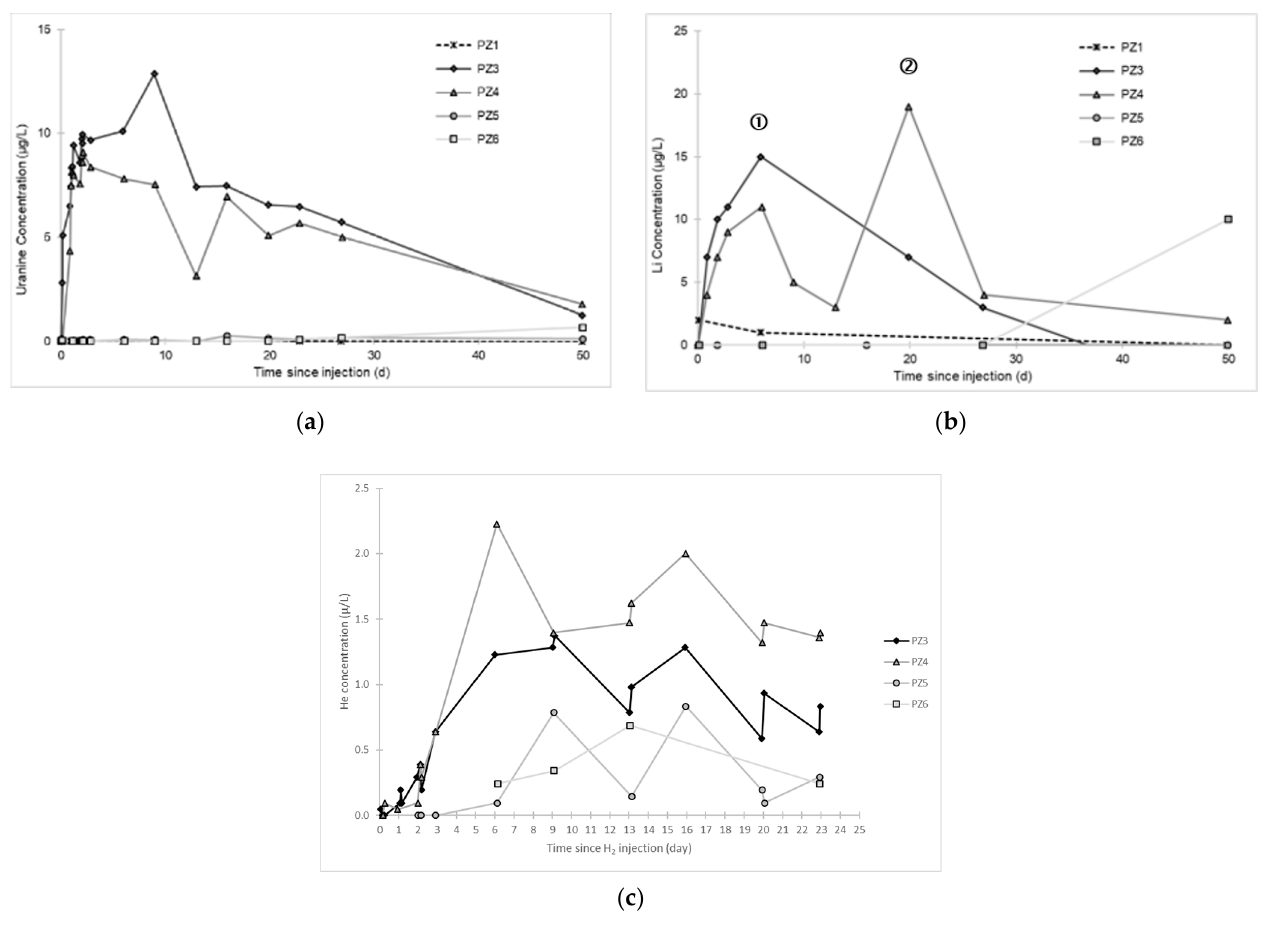
Figure 11. Breakthrough curves for the hydrogeological tracers at the other downstream piezometers: ( a ) uranine; ( b ) lthium; and ( c ) helium.